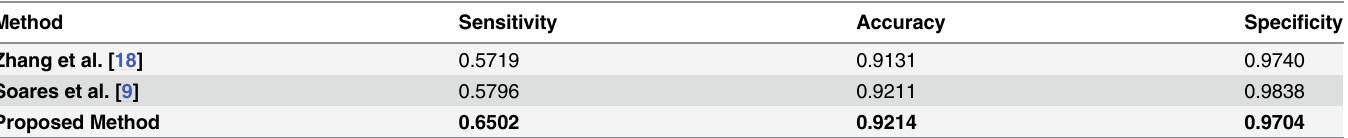
Table 3. Performance of vessel segmentation methods using STARE dataset (i.e., the second manually segmented dataset as the “ gold standard. ” ).